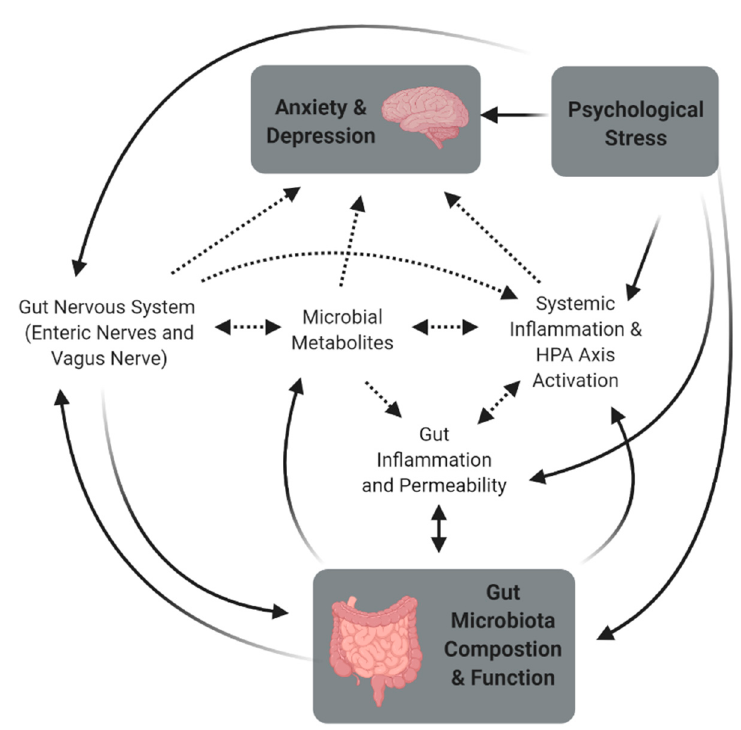
Figure 1. The proposed mechanisms of the microbiome-gut-brain axis (MGBA) are complex and intertwined. Emerging research shows that psychological stress interacts not only directly with the brain and mood, but also with many of the MGBA mechanisms thought to contribute to changes in mood with alteration of the gut microbiota. Solid lines indicate strong evidence of an effect, and dotted lines show proposed mechanisms with limited but emerging evidence. Abbreviations: HPA; Hypothalamic-Pituitary-Adrenal.